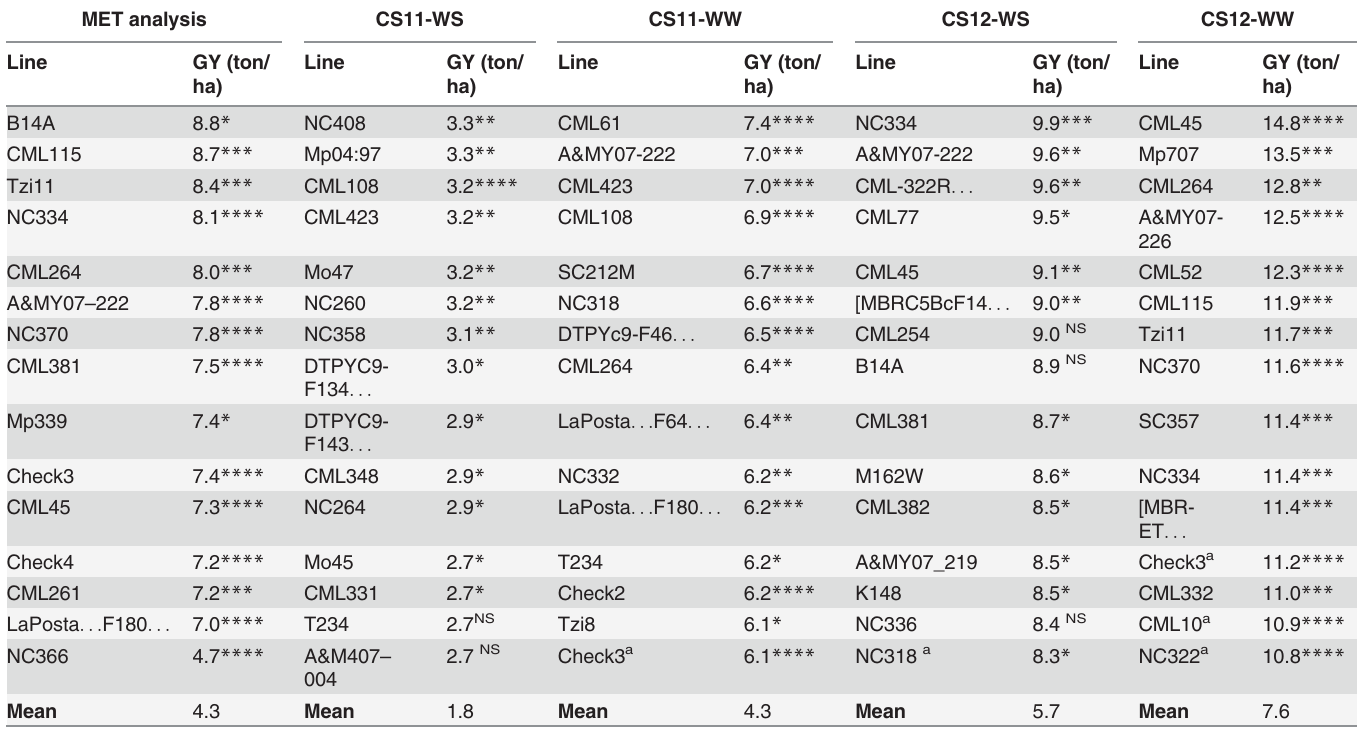
Table 6. BLUPs for the best 15 grain yield (GY) hybrids for all the trials and the MET analysis. MET